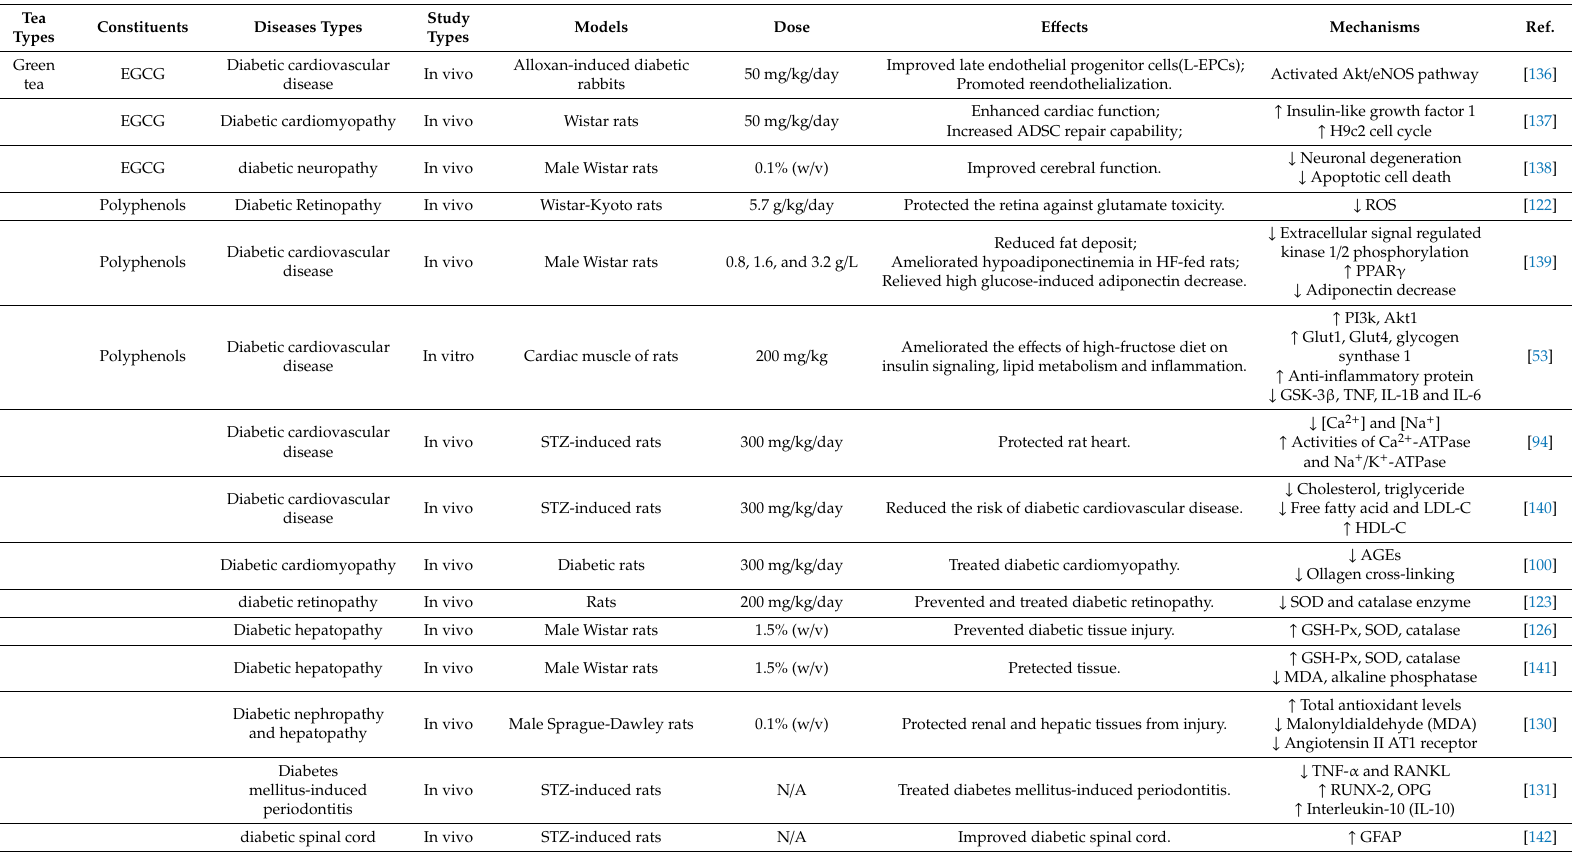
Table 2. The e ff ects of tea on diabetes mellitus and its complications by in vitro and in vivo